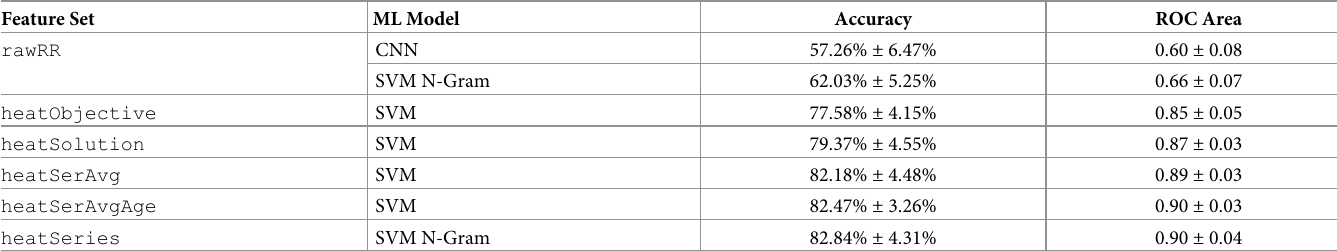
Table 2. Average accuracies and areas under receiver operating characteristic (ROC) curve with standard deviations for the different